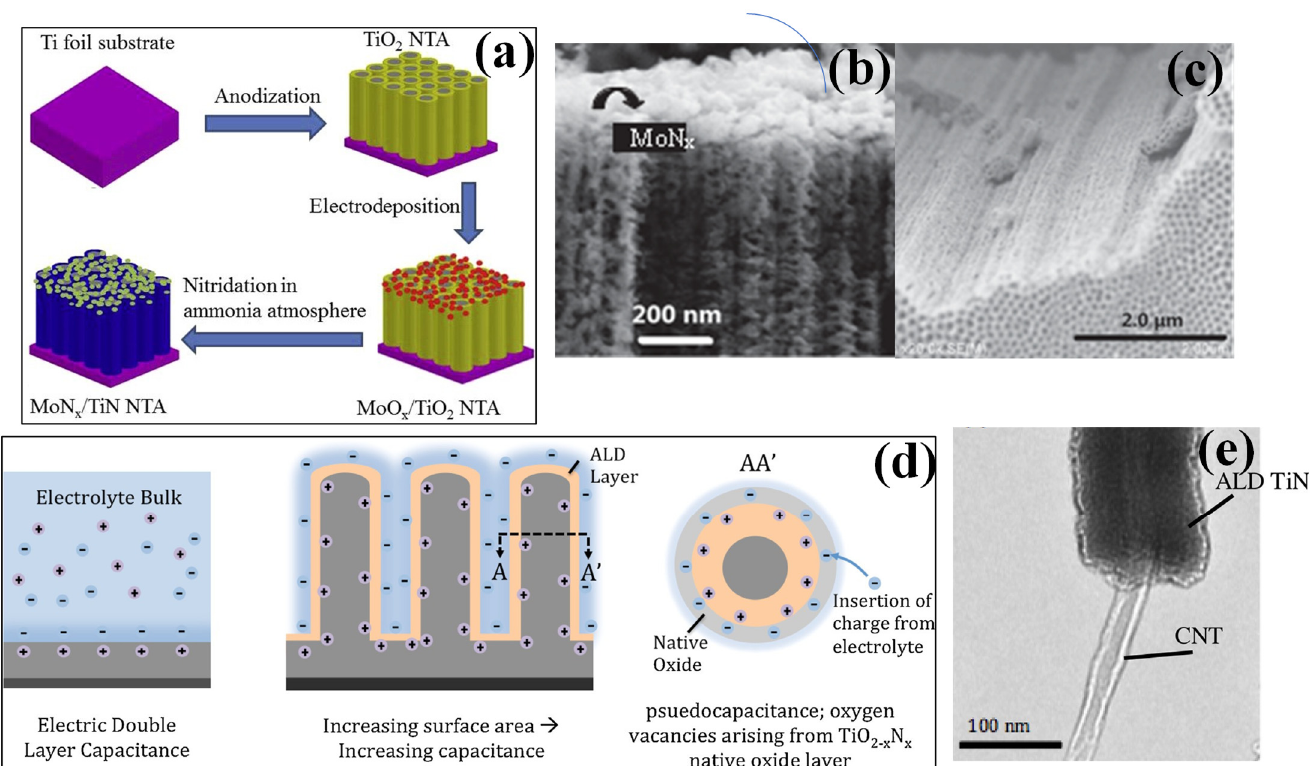
Figure 3. ( a ) The experimental procedure and synthesis mechanism of MoNx − TiN NTAs using electrochemical deposition process, ( b ) SEM image of side view for TiN nanotubes, and ( c ) SEM images of the side view of MoNx − TiN nanotube arrays respectively [72], reproduced with permission, copyright 2016, Elsevier. ( d ) Conceptual representation showing the effect of increased surface area on the capacitance and a rise in pseudo capacitive effect. ( e ) TEM image of ALD-grown TiN coated with the carbon nanotube showing a uniform coating with a layer of around 20 nm respectively [79], reproduced with permission, copyright 2016, Elsevier.